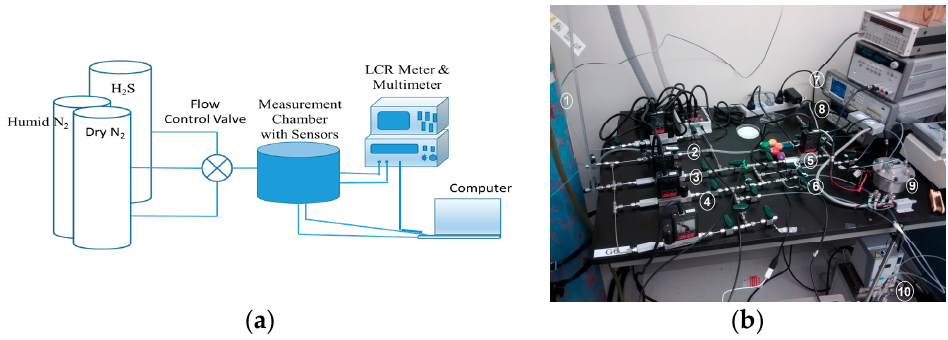
Figure 6. Measurement setup for humidity and gas sensing. ( a ) Block diagram; ( b ) Laboratory setup. 1. Gas cylinder. 2. MFC (Mass Flow Controller) connected to H 2 S gas. 3. MFC connected to dry